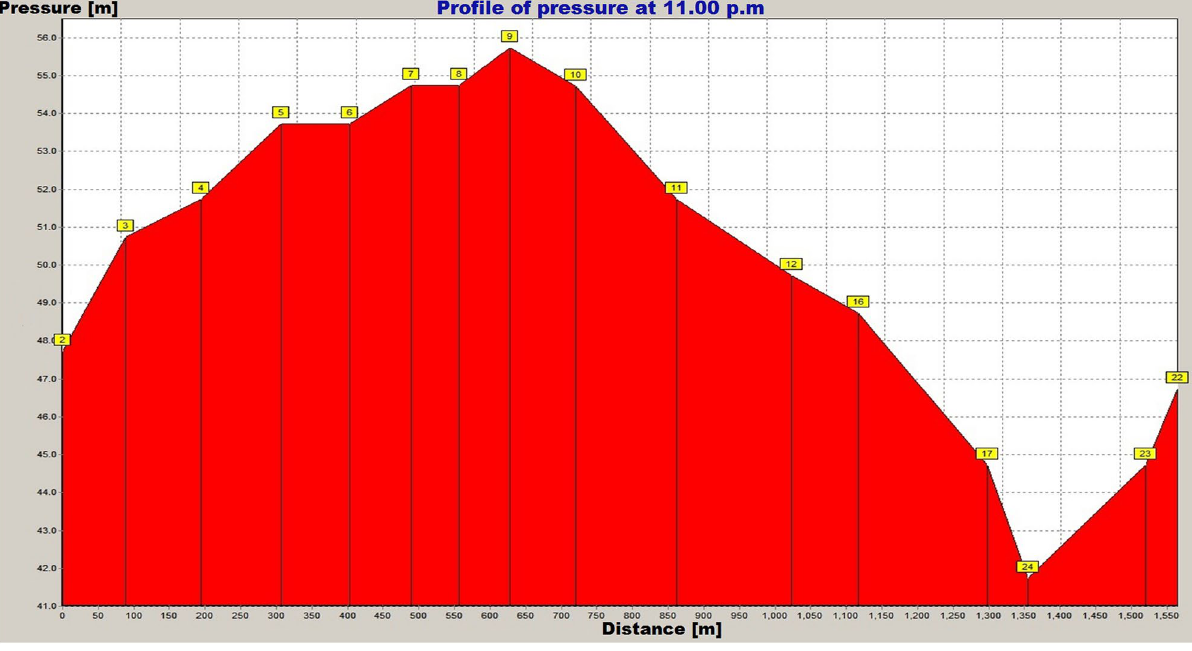
Fig. 8 Pressure profile in the nodes of the main trunk line at the hour of the lowest